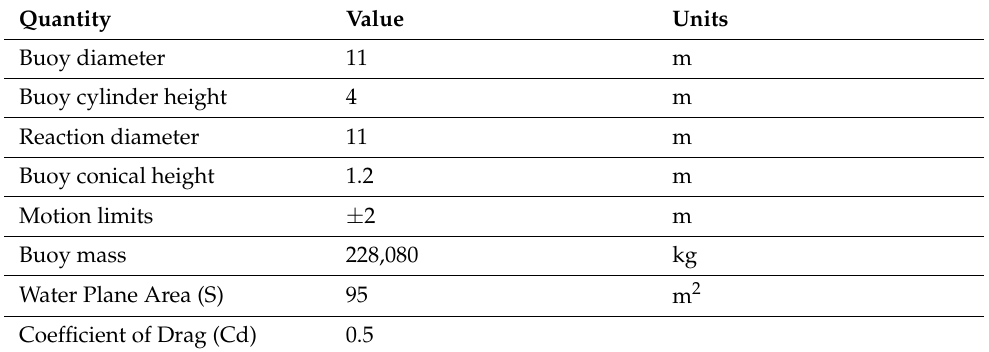
Figure 3. Schematic of the heaving wave-energy converter. Table 1. Dimensions and physical parameters of the heaving wave energy converter.